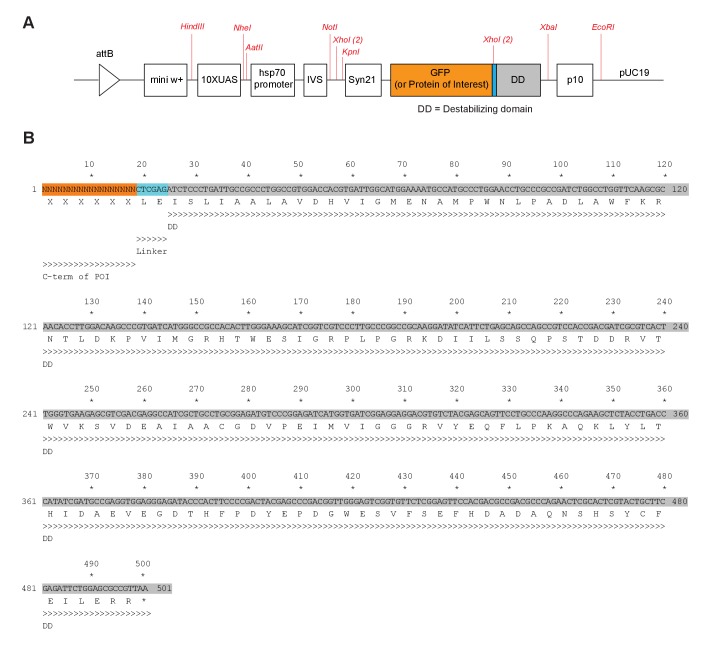
GFP-DD construct and sequence of the destablizing domain.(A) Schematic of the 10XUAS-GFP-DD construct. Restriction sites are shown in red to facilitate cloning. All shown sites are unique apart from XhoI which has two cut sites (both shown). (B) DNA and protein sequence of the destabilizing domain.